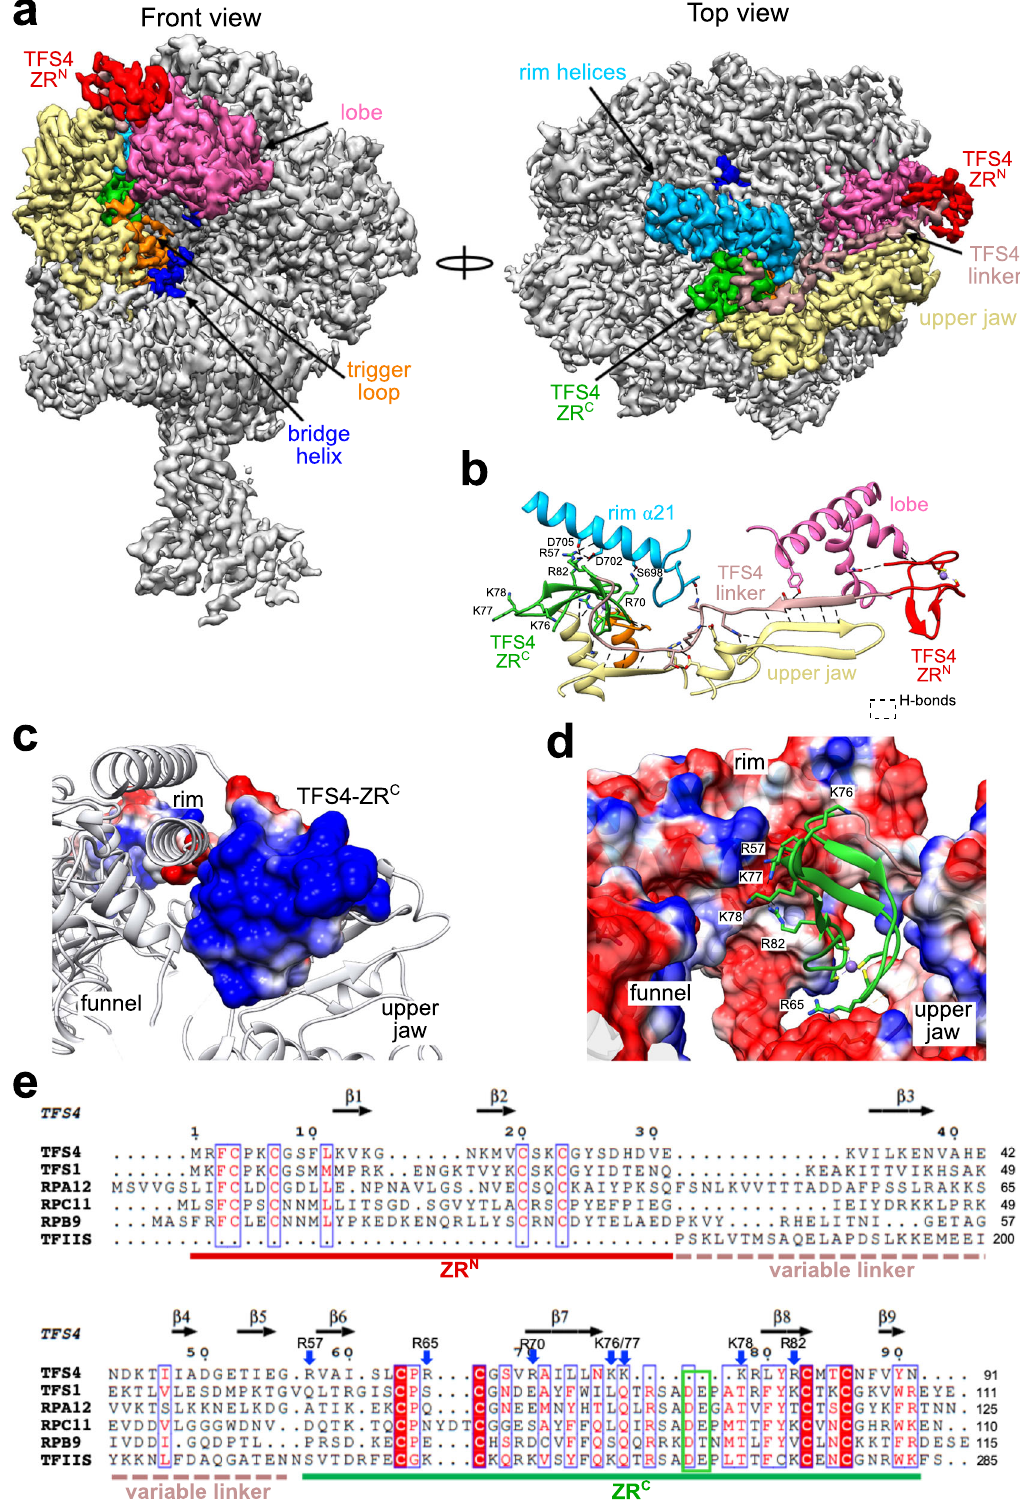
the TFS4 ZR C density and loss of structural information between residues R86 to E95 of Rpo1 ″ in the RNAP – TFS4 cryo-EM